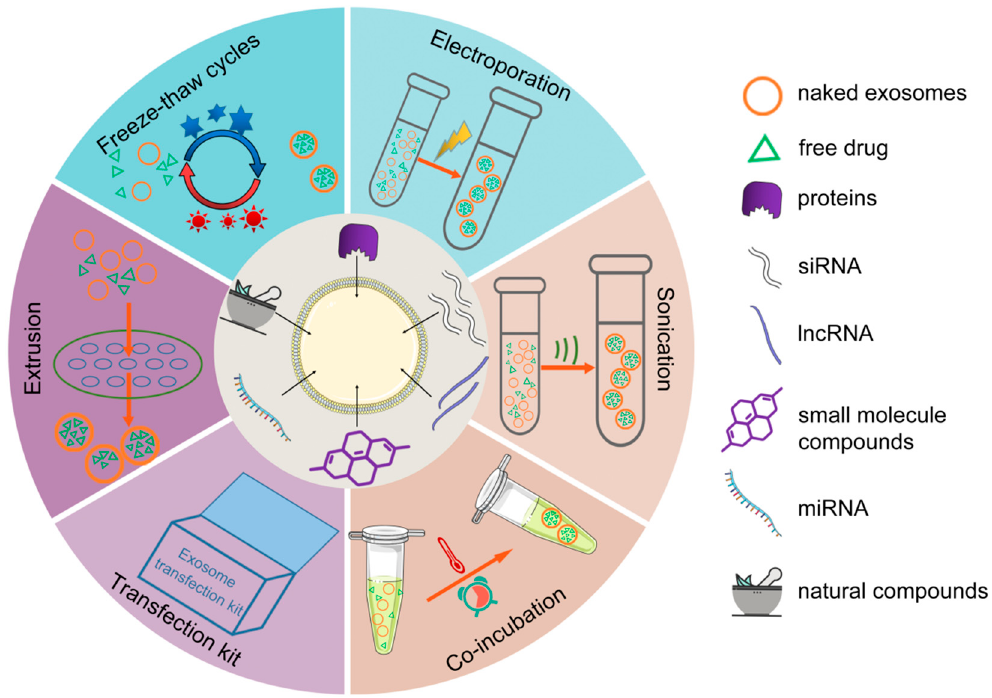
Figure 3. Post-secretory loading methods of exosomes. Drug encapsulation strategies for isolated exosomes include sonication, electroporation, co-incubation, freeze-thaw cycles, extrusion, transfection kits, etc.